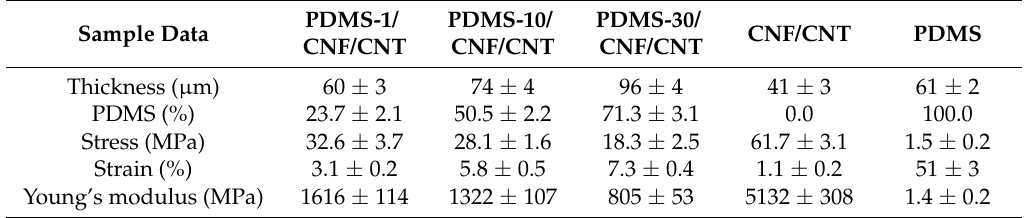
Figure 6. Tensile stress-strain curves of the CNF/CNT and PDMS/CNF/CNT composite film in different PDMS content. Table 1. Tensile properties of the PDMS, CNF/CNT, and PDMS/CNF/CNT